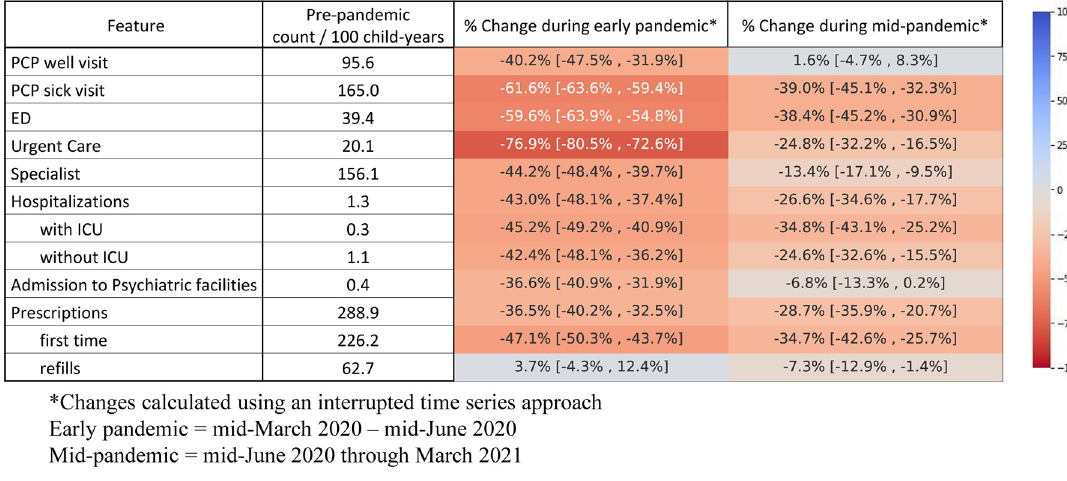
Fig 2. Pandemic changes in healthcare utilization with heat map.